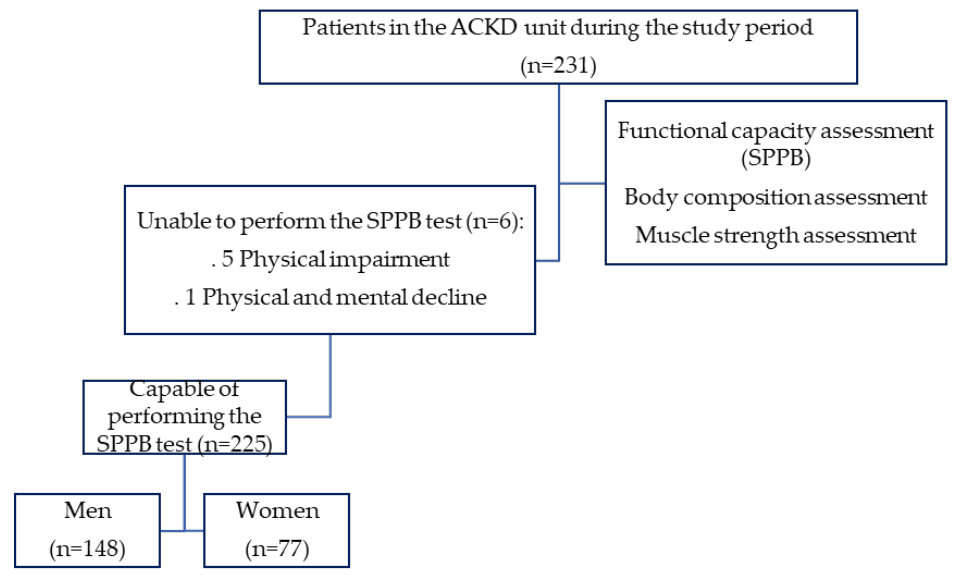
Figure 2. Study flowchart.